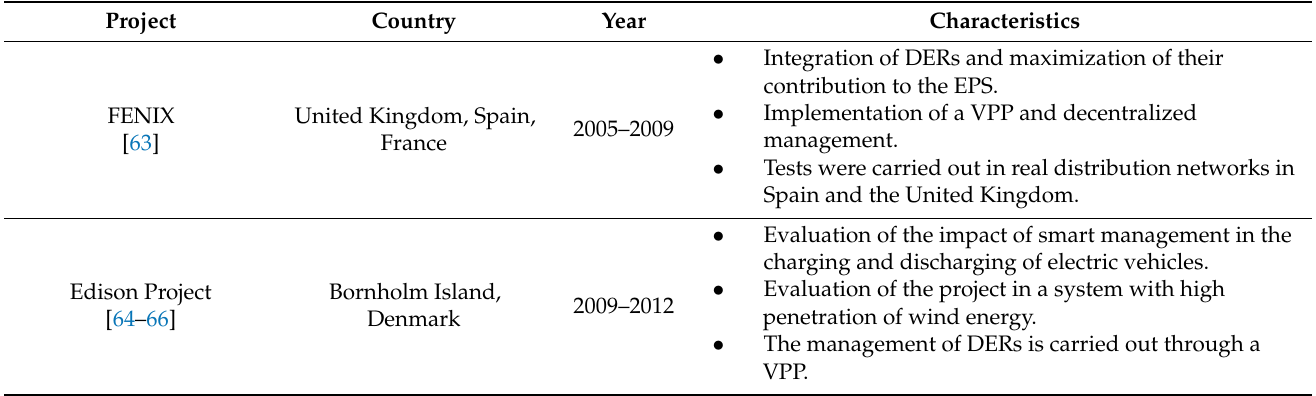
Table 2. Worldwide developed projects’